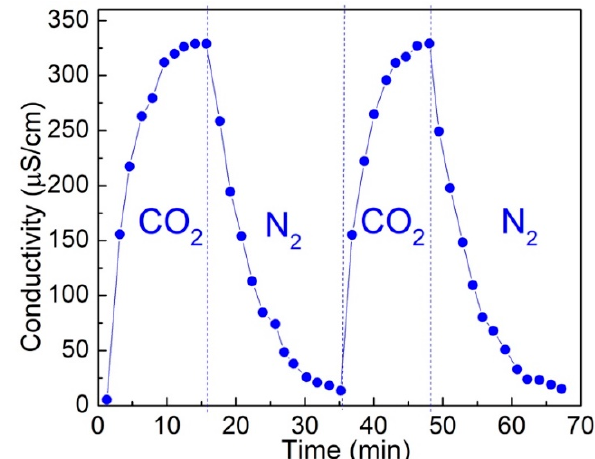
Figure 1. Conductivity of aqueous solution of oligochitosan (0.2 wt.%) against time during two cycles of sparging CO 2 and N 2 at 25 ± 0.5 °C.